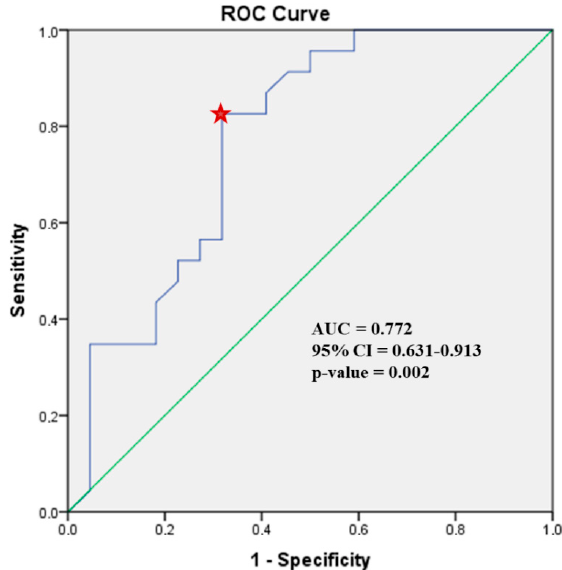
Figure 3. Receiving operating characteristic (ROC) curve analysis identified a left atrial peak strain of 31.5%, as the best cut-off value with 83% sensitivity, 68% specificity and Youden index 51% (red star), for prediction of PACs > 24/day (area under the curve AUC 0.772, 95% confidence interval CI 0.631 – 0.913, p -value 0.002) in β -TM patients.